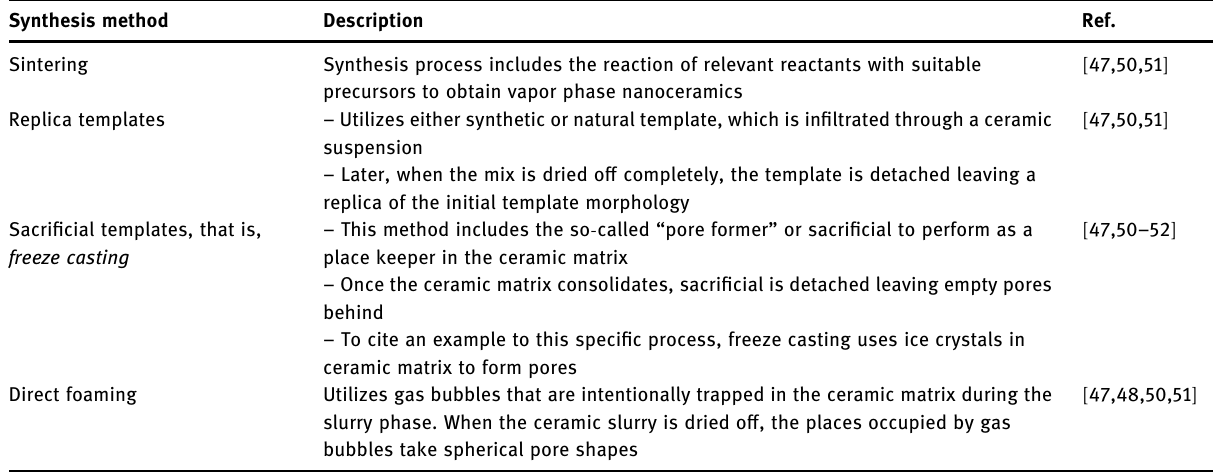
Table 3: Processing techniques of porous